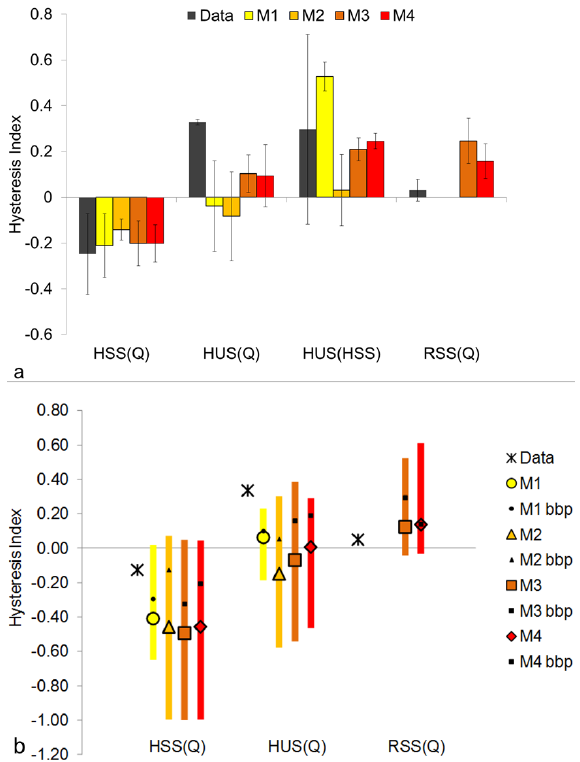
Figure 11. (a) Mean annual hysteresis indexes observed and simu- lated with the four models M1 to M4 for hillslope saturated storage vs. discharge HSS(Q), hillslope unsaturated storage vs. discharge HUS(Q), hillslope unsaturated storage vs. hillslope saturated stor- age HUS(HSS) and riparian saturated storage vs. discharge RSS(Q). RSS is only simulated in models M3 and M4. Error bars show the standard deviation for the 10 years for HSS(Q) and RSS(Q) and the values for the 2 available years for HUS(Q) and HUS(HSS). (b) Sensitivity of hysteresis index values to parameter uncertainty for the year 2011–2012. Mx bbp indicates the value for best be- havioural parameter sets; the circles, triangles, squares and dia- monds indicate the mean HI value for the all the behavioural param- eter sets, and the corresponding bars indicate its range of